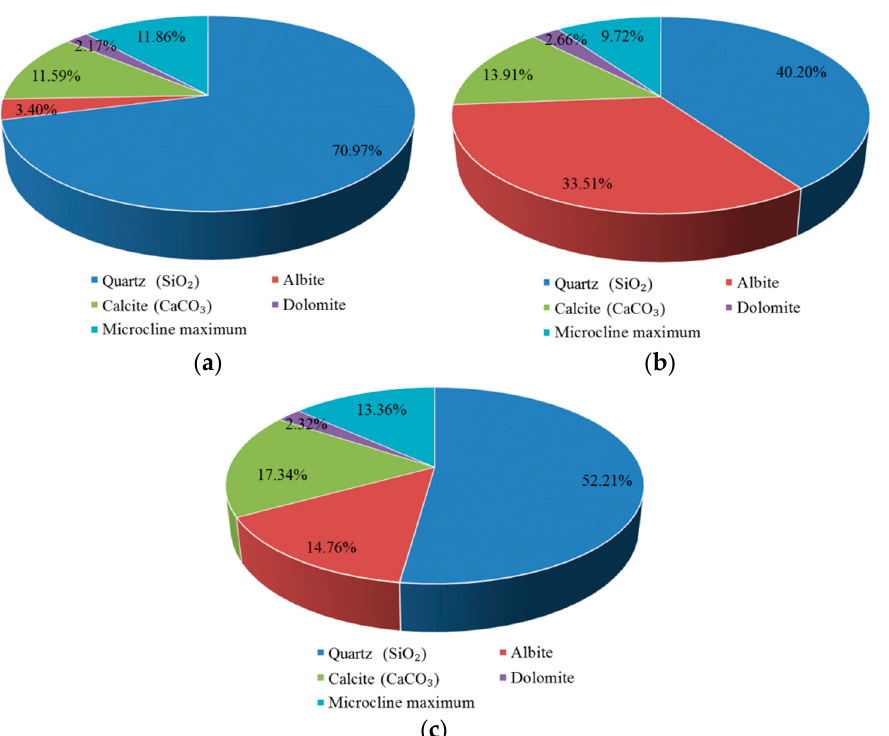
Figure 11. Contribution of chemical phases of carbonation layers in different exposed environments: ( a ) group AI (atmospheric environment), ( b ) group WB (water-immersion environment), and ( c ) group HA (saturated-humidity environment).